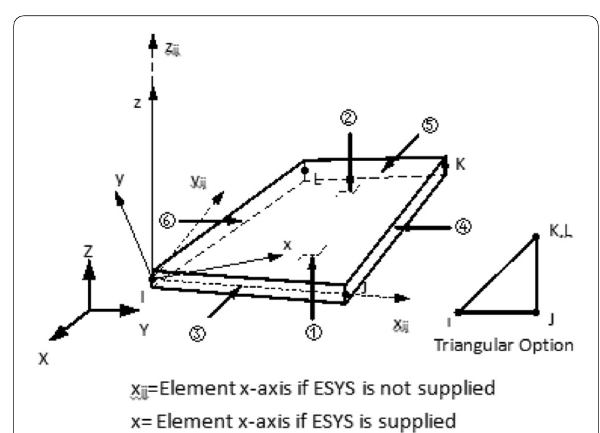
Fig. 11 Details of finite elements: SHELL63 [50]